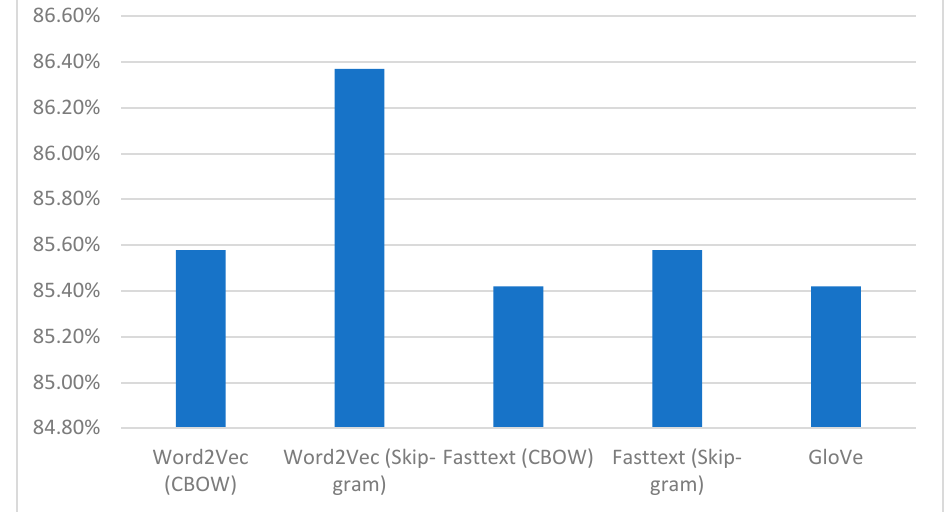
Figure 5 . Accuracy of the LSTM–PCNN model with different word embedding. Figure 5. Accuracy of the LSTM–PCNN model with different word